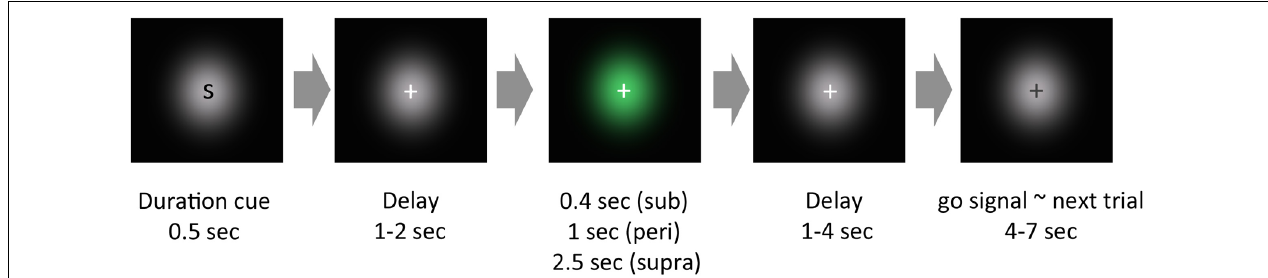
FIGURE 1 | Schematic of an experimental trial. In our experimental paradigm, each trial began with a cue presentation, which roughly informed the subjects of the cue duration to be presented. After a pseudorandom delay, a green Gaussian blob was presented for a certain duration. After another pseudorandom delay, the color of the fixation cross changed from white to black. After this change of color, subjects reproduced the perceived duration of the green stimulus by pressing a